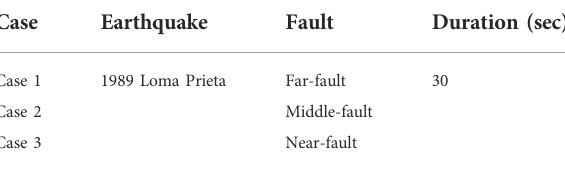
TABLE 7 Three different cases for the 1989 Loma Prieta earthquake (Karalar, 2020).